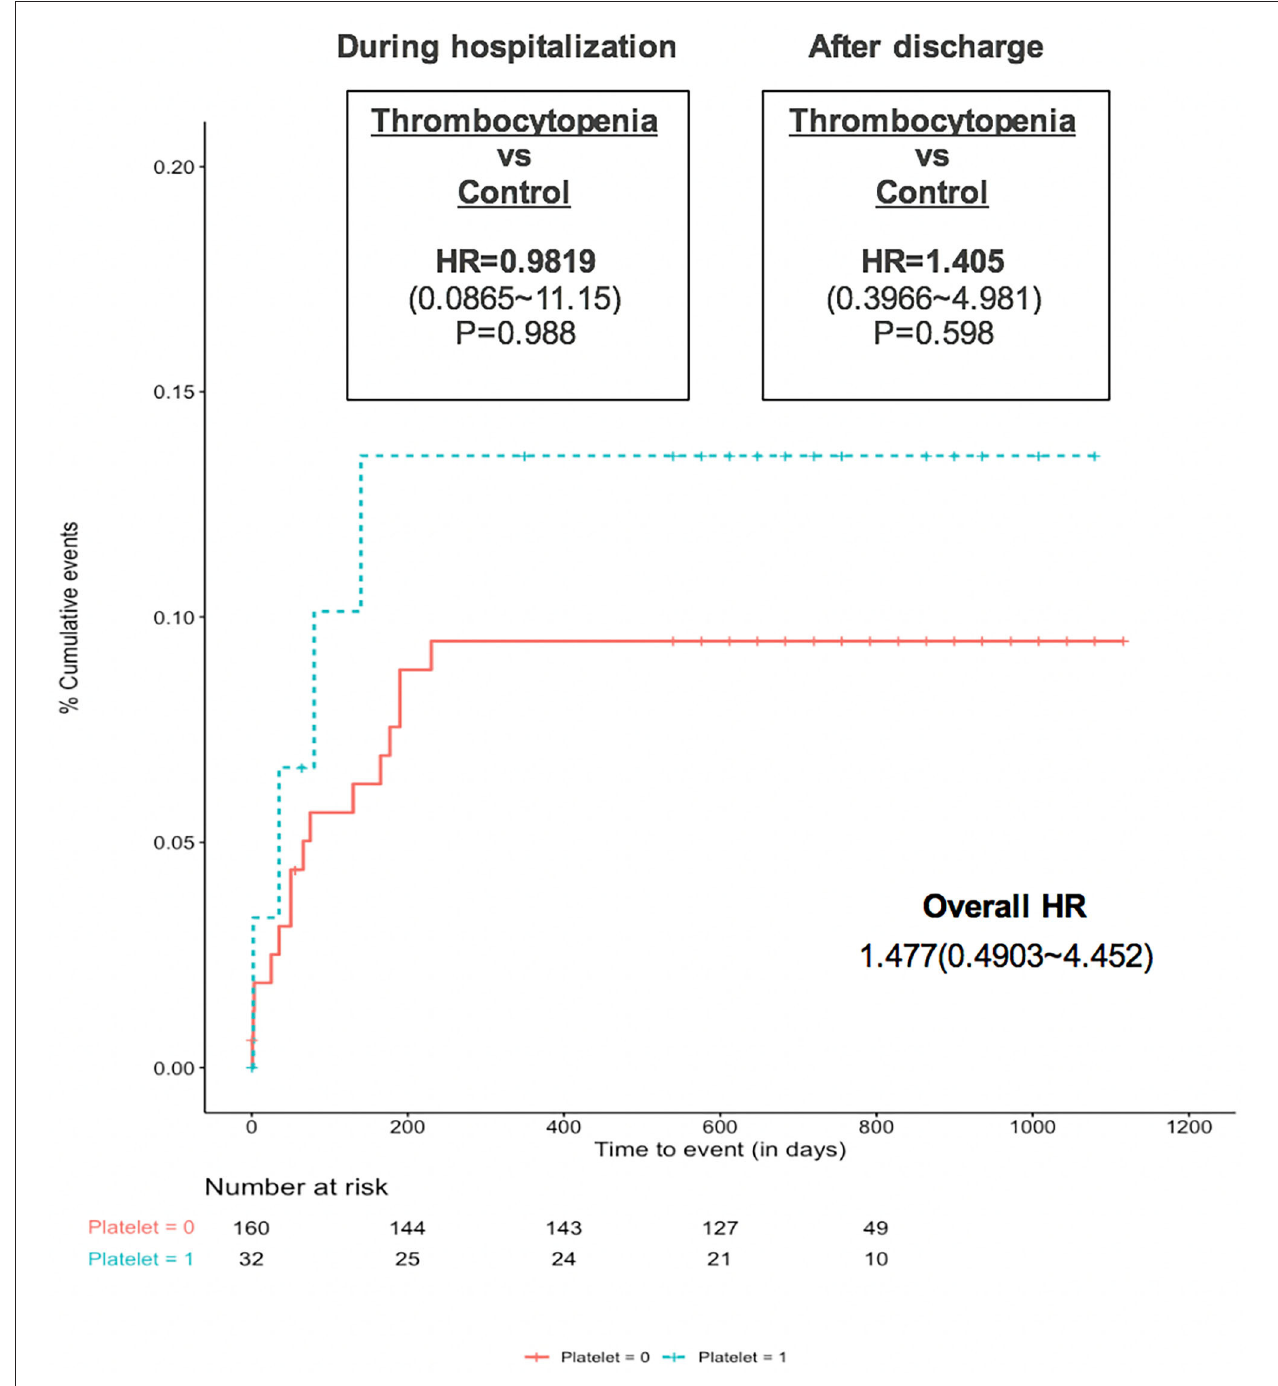
FIGURE 2 | Cumulative incidence of the net adverse event between patients with and without chronic thrombocytopenia (matched cohort).